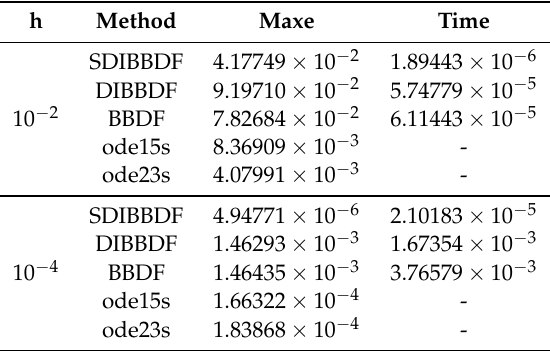
Table 2. Numerical results for test problem